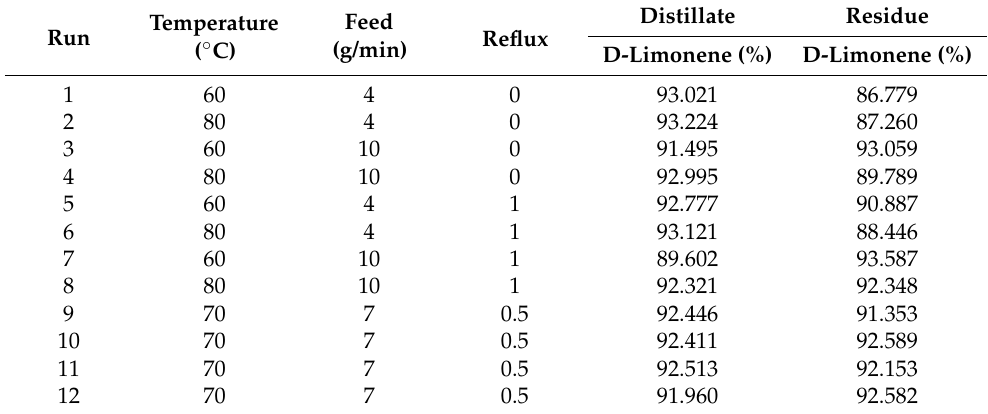
Table 6. Results of D-Limonene percentage according to factorial design of fractional distillation.